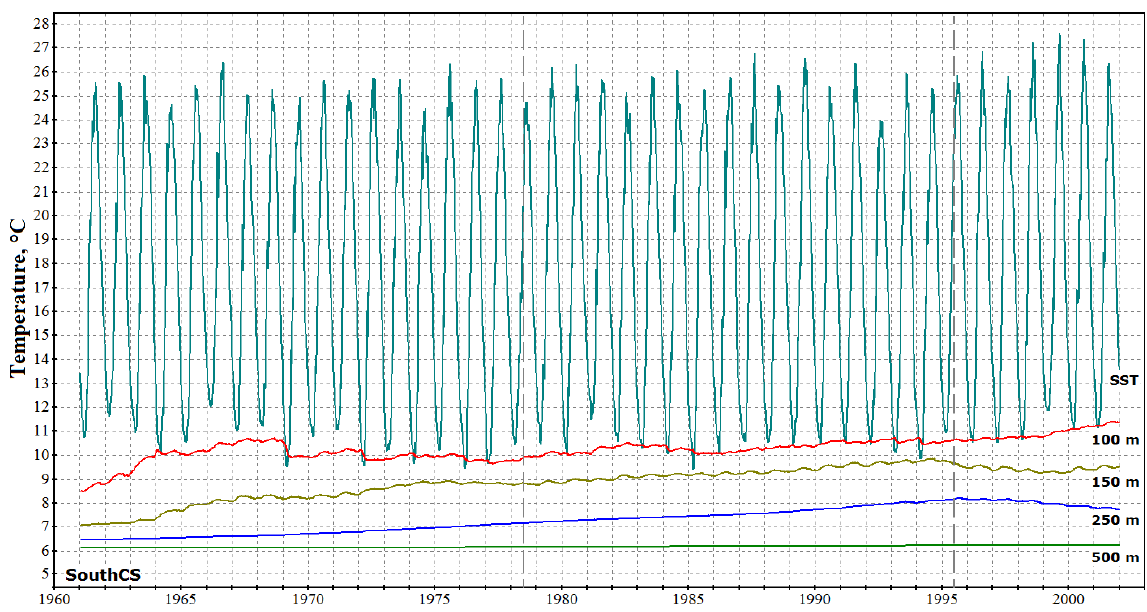
Figure 13. Evolution of temperature at different depths (SST – sea surface temperature) averaged over the SouthCS basin ( ◦